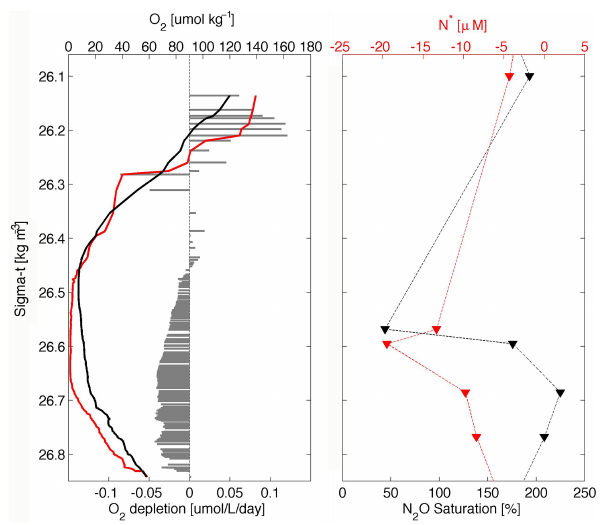
Figure 6. (a) Vertical distribution of Oxygen as a function of σ t at Tara station 094-A (within the eddy) in March 2011 (red line) and at the coast in June 2010 (black line). Estimated O 2 depletion rates are shown as gray bars, where the vertical dotted line marks zero O 2 consumption rate. (b) Vertical distributions of Nitrate deficit (N*) and Nitrous oxide saturation (black triangles and line) as a function of σ t within the eddy at station 094-A.